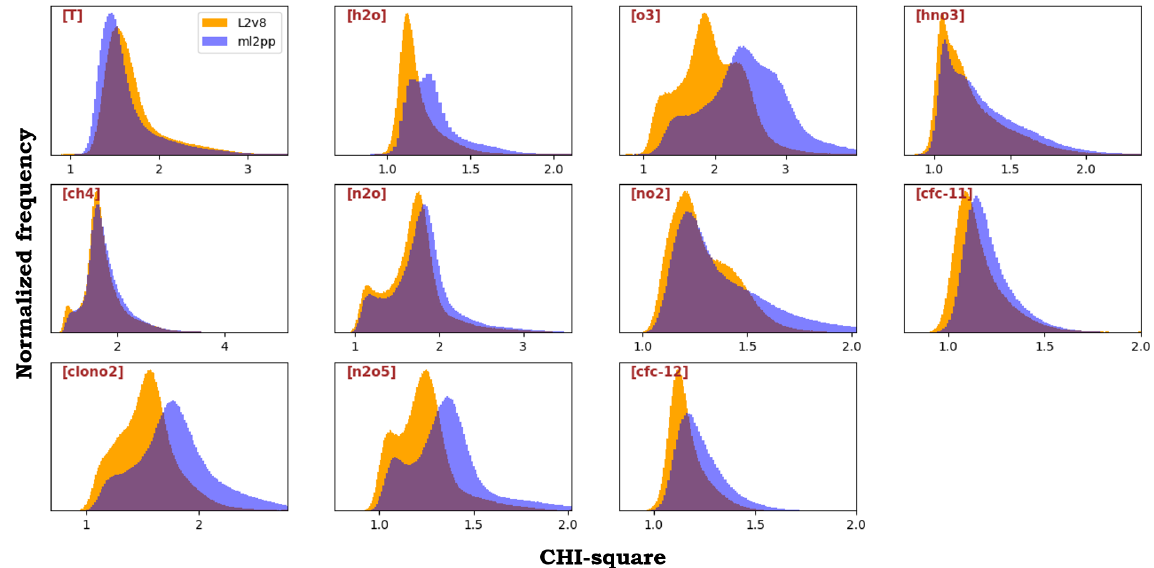
Figure 2. Chi-square distribution of all OR NOM L2 V8 (orange) and L2 V7 (blue) profiles for some representative trace